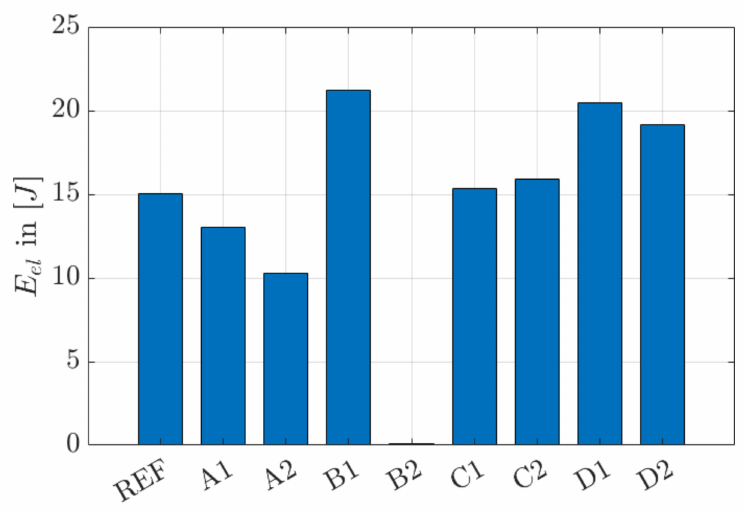
Figure 35. Comparison of the electrical energy conversion for the different